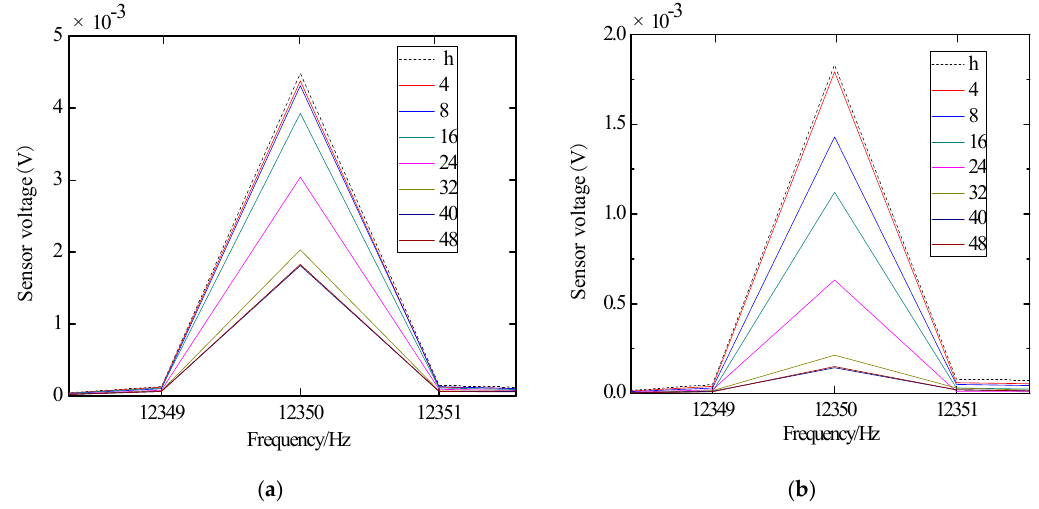
Figure 14. Frequency domain diagram of sine signals received by sensors of specimen JD-2. ( a ) S1-S2; ( b ) S1-S3.